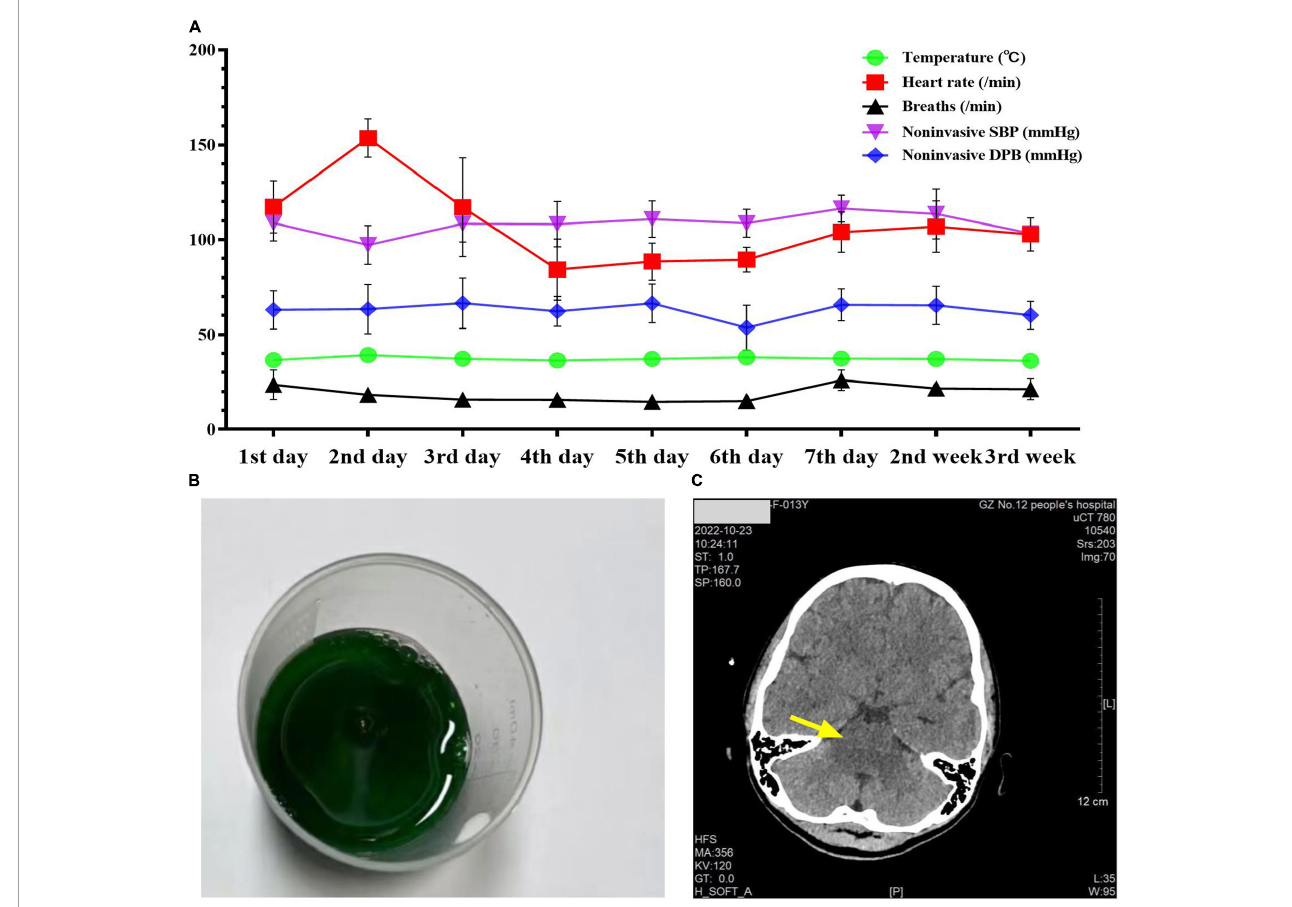
FIGURE1 The patient’s vital signs, urine screening, and cranial CT examination during admission. Panel (A) was the changes in the patient’s vital signs during admission. Panel (B) was the positive urine fast screening of diquat (dark green). Panel (C) was the photograph of cranial CT examination on the 7th day after admission.